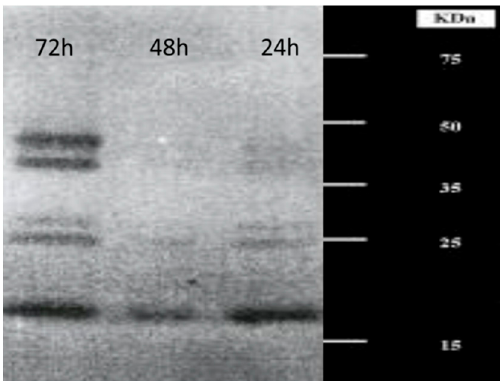
Figure 2. One-dimension activity PAGE for chitinolytic enzymes by Lecanicillium muscarium CCFEE 5003 produced in shaken cultures at different times: 24 h, intracellular activity; 48 and 72 h extracellular activity. Molecular weight markers are shown in the range 15–75 kDa (unpublished picture related to [19]).